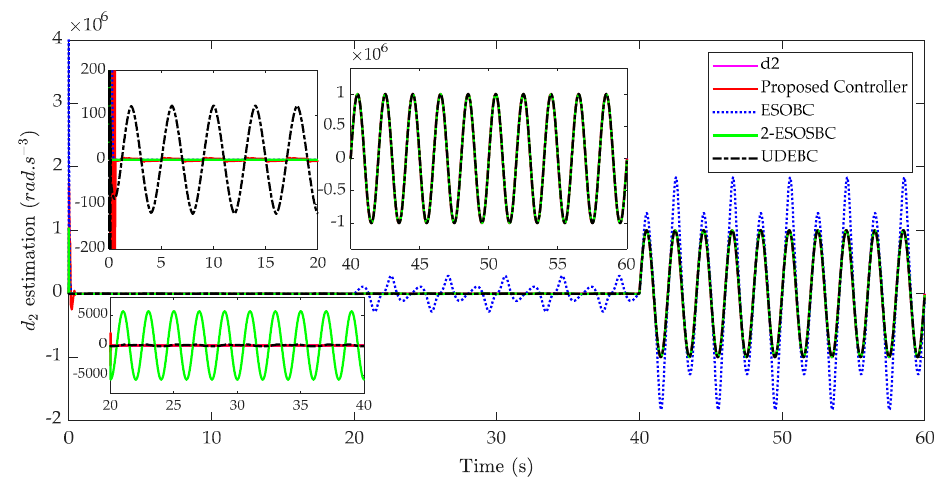
Figure 9. The estimation of the matched disturbance.